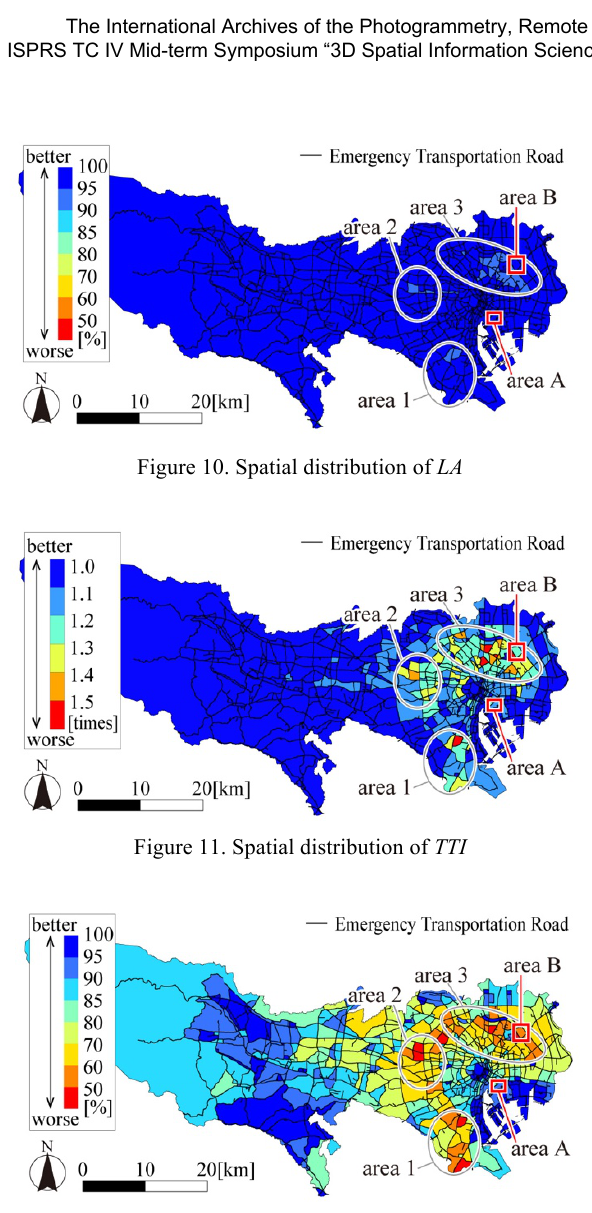
Figure 12. Spatial distribution of LAP